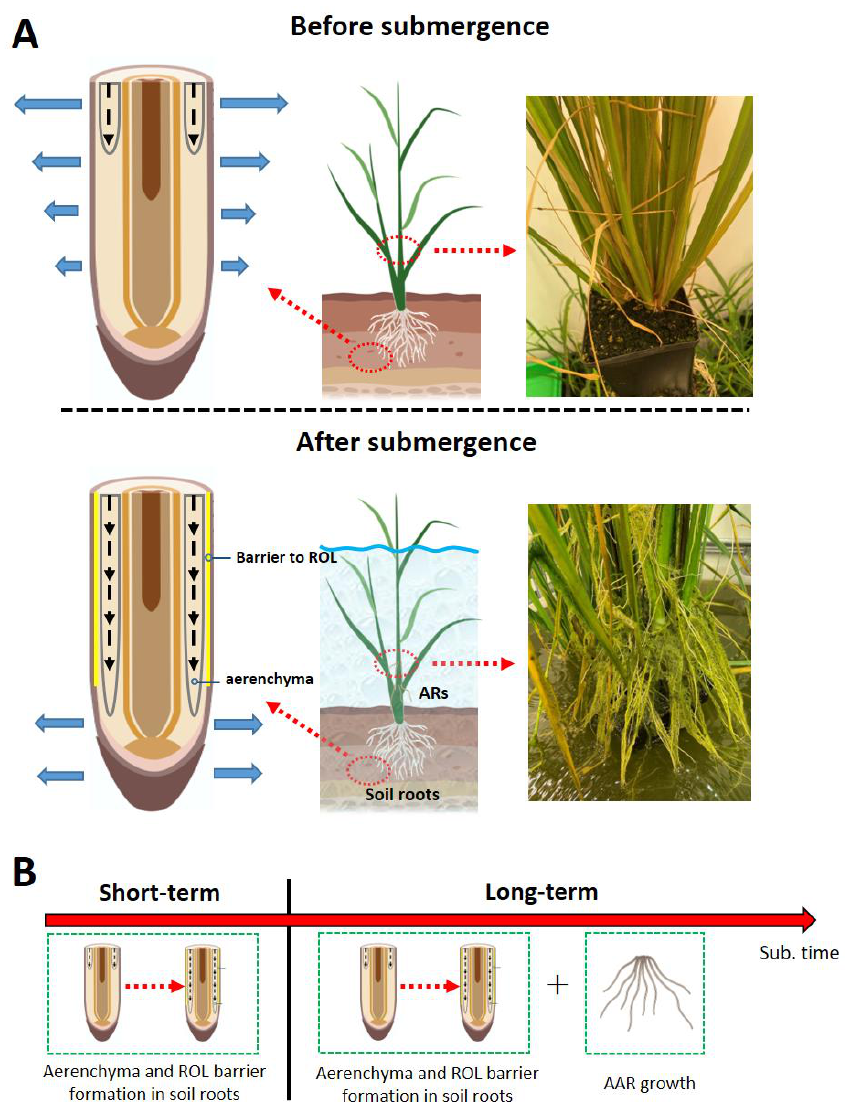
Figure 2. Three adaptive root traits conferring tolerance to soil flooding in rice. ( A ) The inducible aerenchyma is developed inside the soil roots to enhance O 2 diffusion from the shoot to the root. A barrier to radial oxygen loss (ROL) is formed at the outer part of the soil roots to restrict loss of molecular O 2 to the anoxic rhizosphere. Furthermore, the shoot-borne aquatic adventitious roots (AARs) are formed aboveground. ( B ) Roots adaptive traits occur as the flooding progresses. Several components are created with